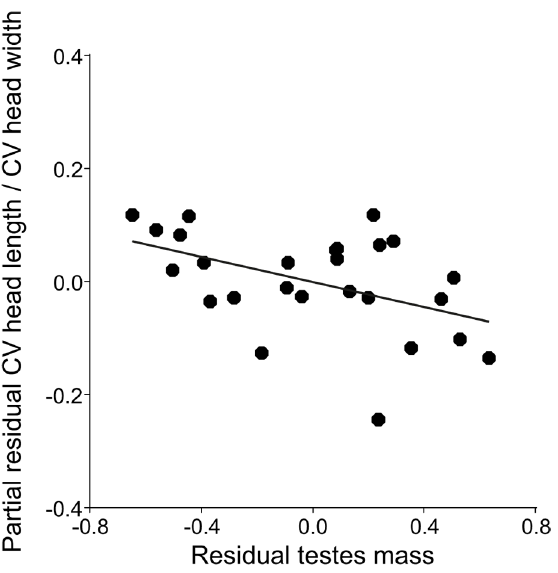
Figure 3. Relationship between residual testes mass and the ratio between coefficients of variations (CV) of head length and head width of several sperm components.